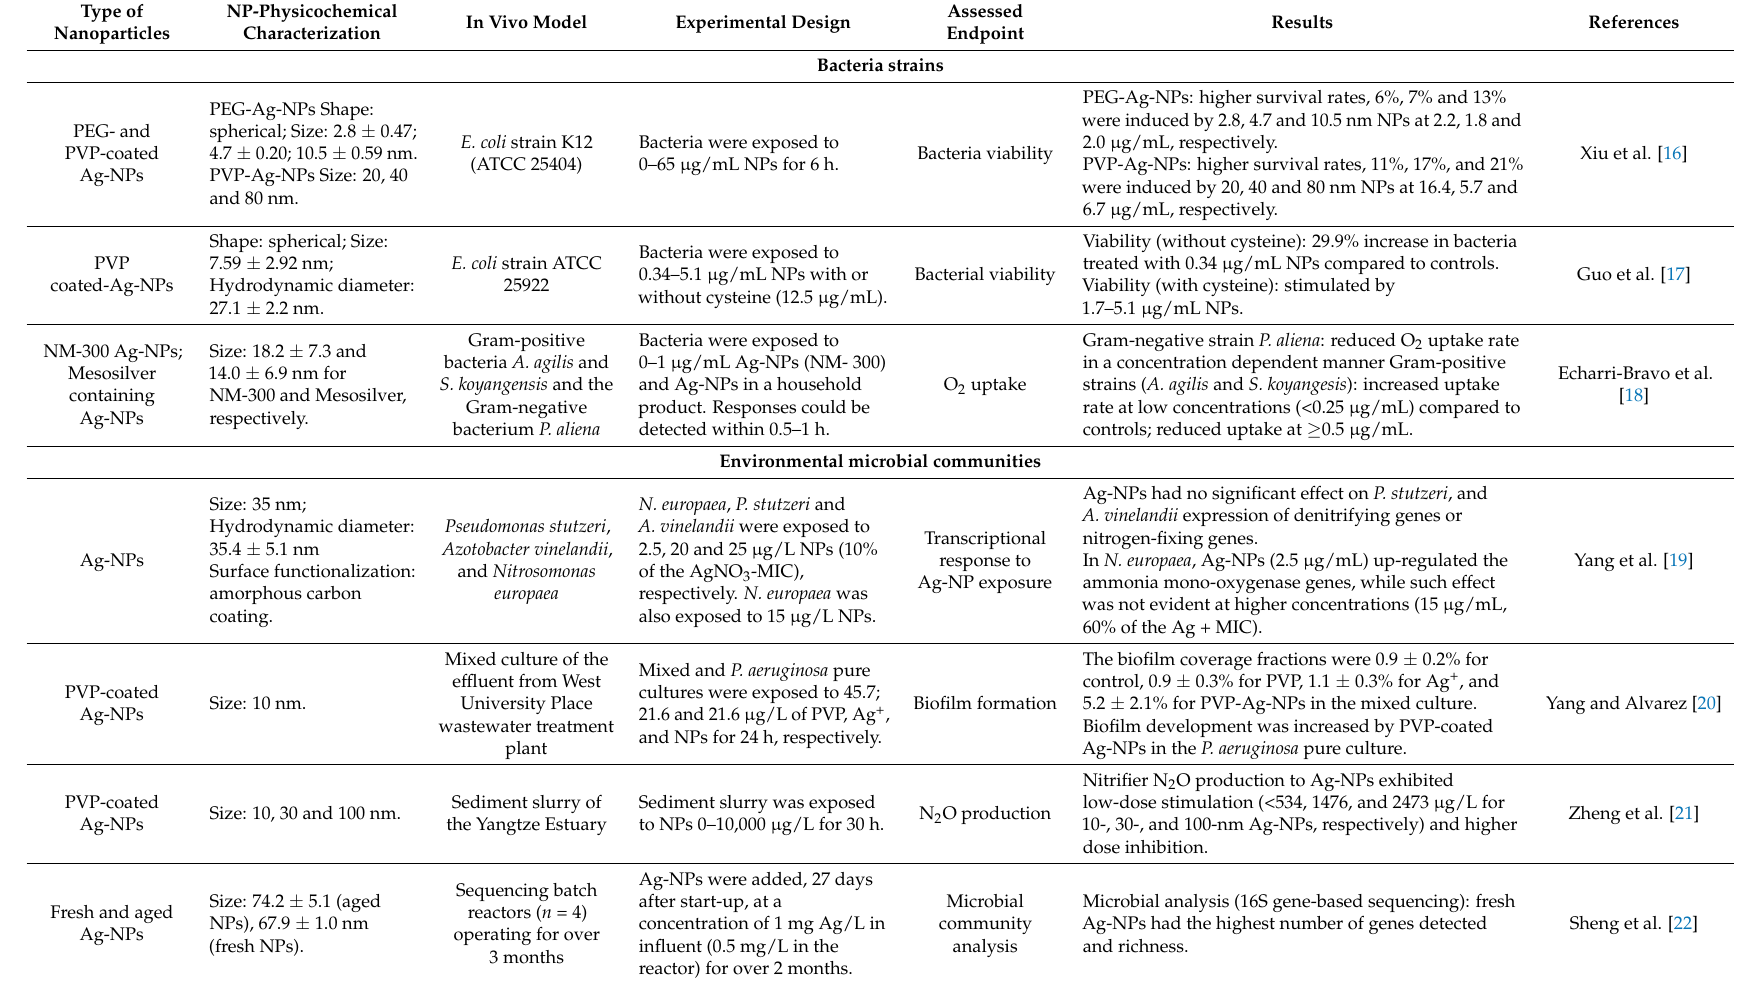
Table 2. In vivo studies demonstrating the presence of a nanoparticle induced hormetic